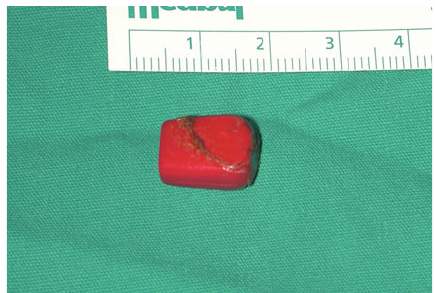
Figure 1: Computed tomography section that shows the foreign body in the right side of the neck (arrow).